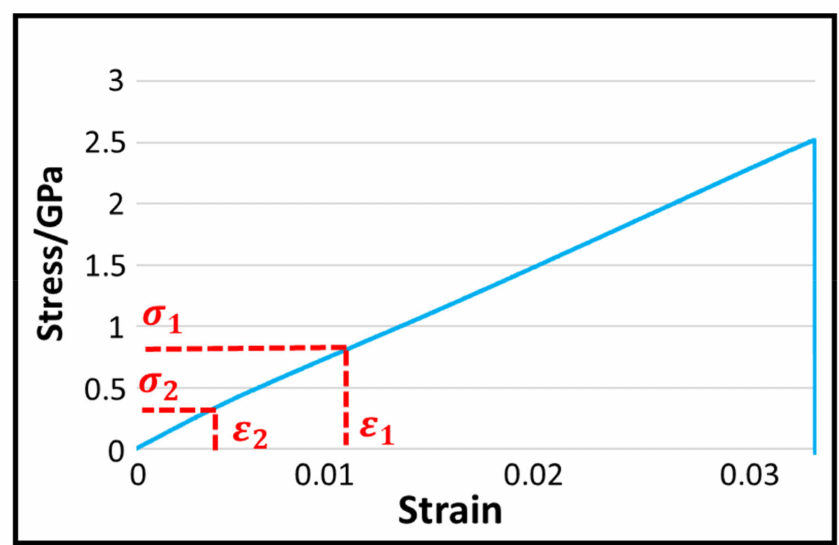
Figure 4. Tensile mechanical properties of the Kevlar yarns.